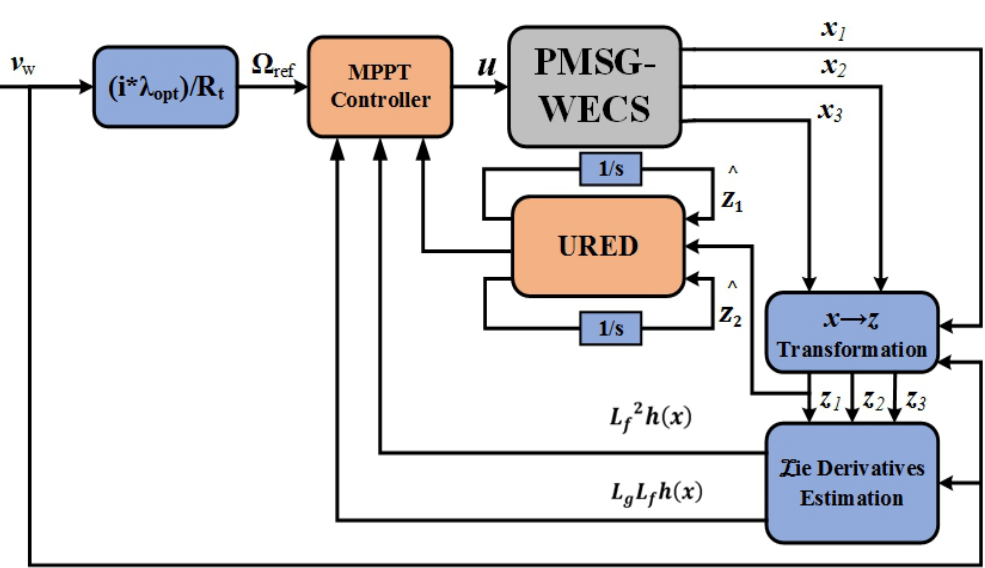
Figure 4. Closed-loop observer-based SMC PMSG-WECS